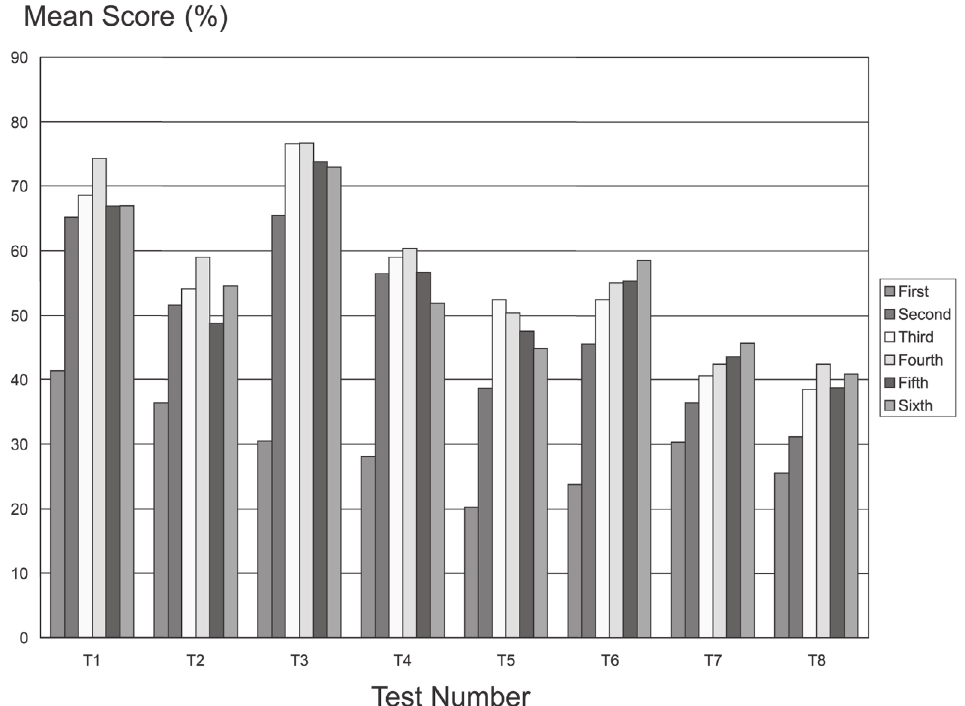
Figure 2 - Mean scores (%) for basic science questions, for students from first to sixth year, according to occasion on which the test was applied (tests 1-8). (tests 1, 3, 5, 6, 7 and 8 P < .0001; test 2, P = .04; test 4, P = .03). *For each sequence of columns, the first represents first-year students; the second, second- year students; the third, third-year students; the fourth, fourth-year students; the fifth, fifth-year students; and the sixth, sixth-year students.